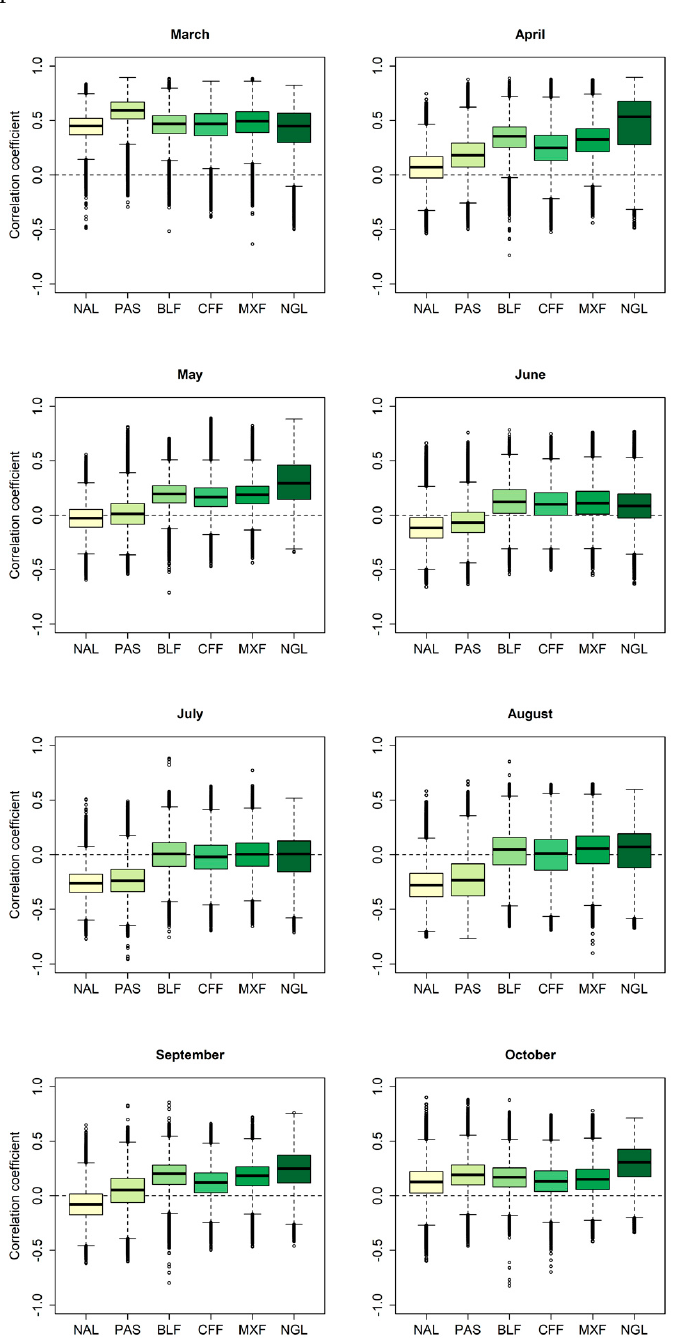
Figure 4. Pixel-based monthly correlation coefficients (Bravais-Pearson) between 8-day NDVI and LST by land cover in Bavaria from 2001 to 2020. Land cover classes according to CLC 2018 (Table 2) are non-irrigated arable land (NAL), pastures (PAS), broad-leaved forest (BLF), coniferous forest (CFF), mixed forest (MXF), and natural grasslands (NGL). Thirdly, monthly NDVI-LST correlations vary with altitude in Bavaria (Figure 5). Ex- cept for the altitude level above 1200 m in March, the correlation coefficients increased con- tinuously with altitude in all months. Negative correlations were on average only achieved at altitudes up to 800 m, and at altitudes below 300 m, the median of the correlation coeffi- cients was clearly negative (from June to September). When combining altitude and land